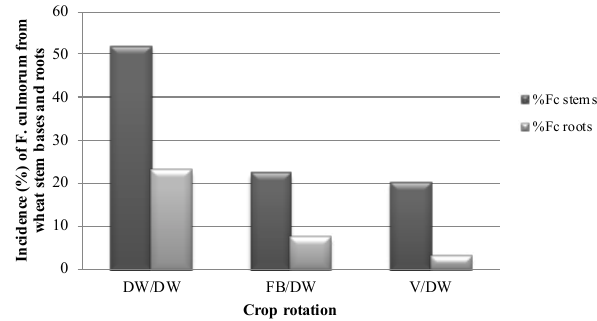
Figure 5. Mean incidence of Fusarium culmorum (Fc) from durum wheat stem bases and roots from three demonstration trials, after previous crops of durum wheat faba bean and